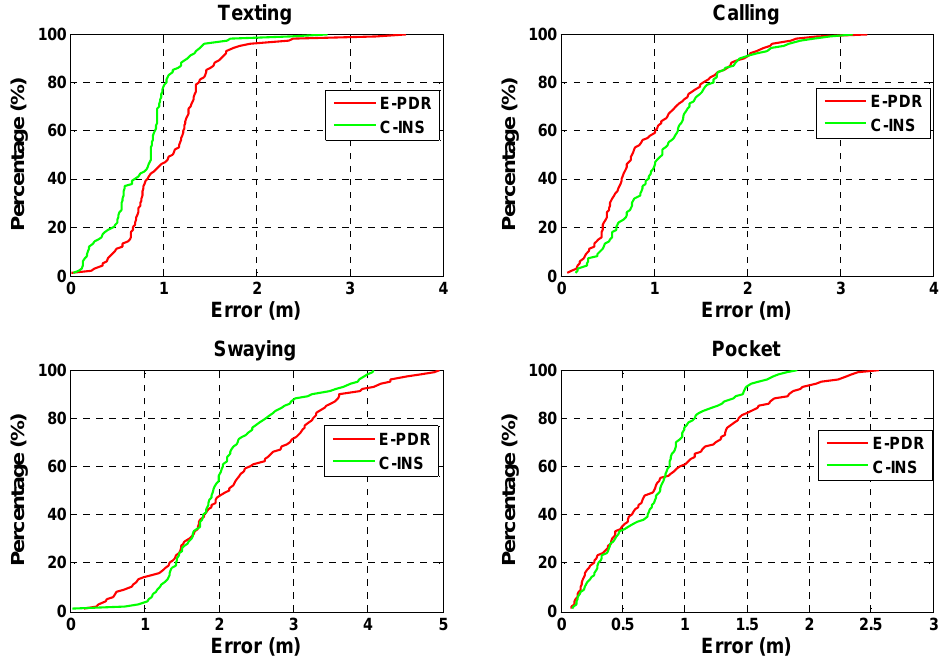
Figure 9. Position cumulative error percentages of E ‐ PDR and C ‐ INS solutions for four different phone ‐ holding positions. Table 2. Position errors of E ‐ PDR and C ‐ INS solutions for four different phone ‐ holding positions (units of m).